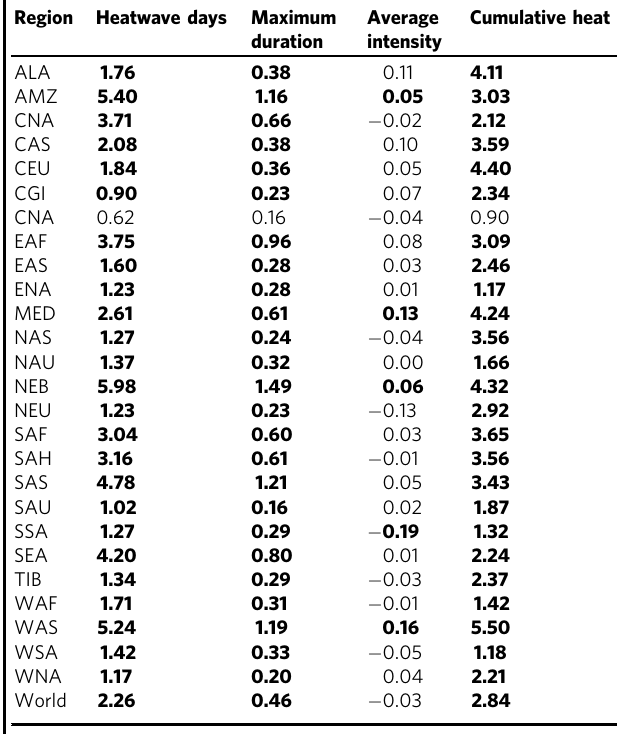
Table 1 Decadal trends in seasonal heatwave characteristics. Region Heatwave days Maximum